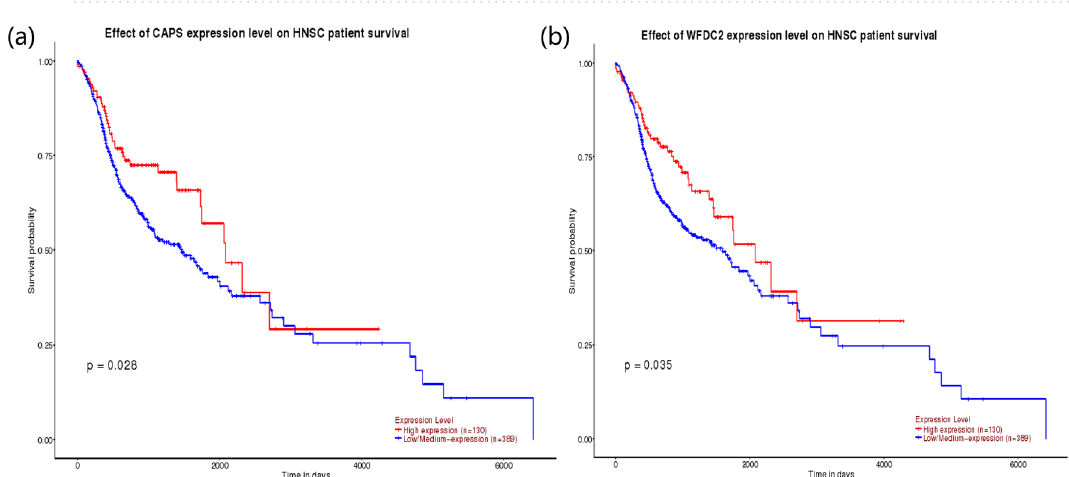
Figure 7. Kaplan Meier’s survival analysis. Effect of ( a ) CAPS and ( b ) WFDC2 expression level on head and neck squamous cell carcinoma patient survival. Down-regulation of CAPS and WFDC2 can prolongation of the overall survival periods in the patients. The picture was drawn using R programming language (https:// www.r- proje ct. org/,